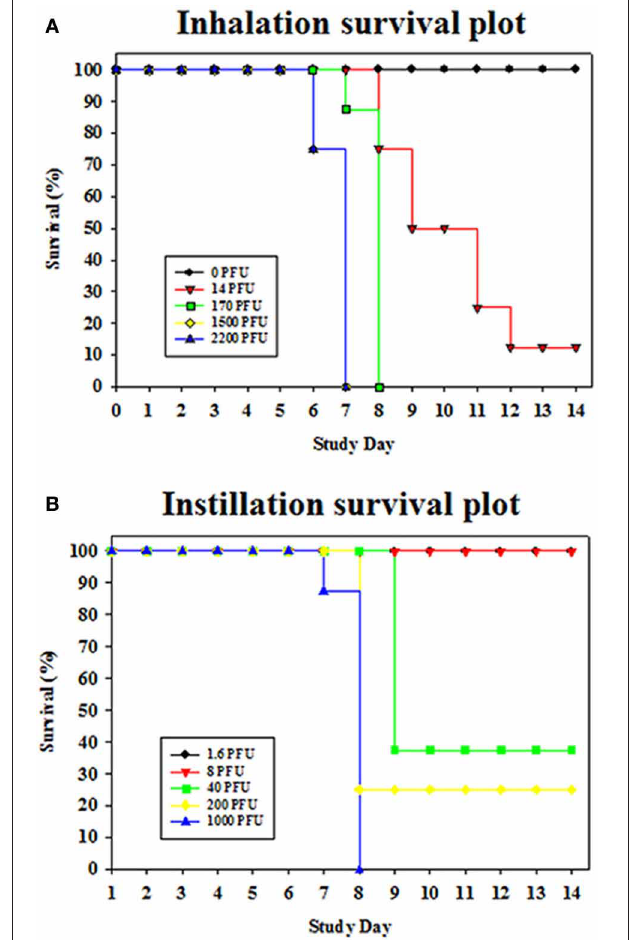
FIGURE 2 | (A) Inhalation and (B) instillation survival plots for mice exposed to PR8. A key indicating color code for each dose group is provided on the